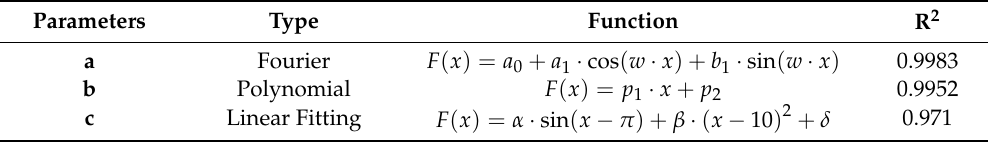
Table 3. Parameter fitting Functions and R 2.